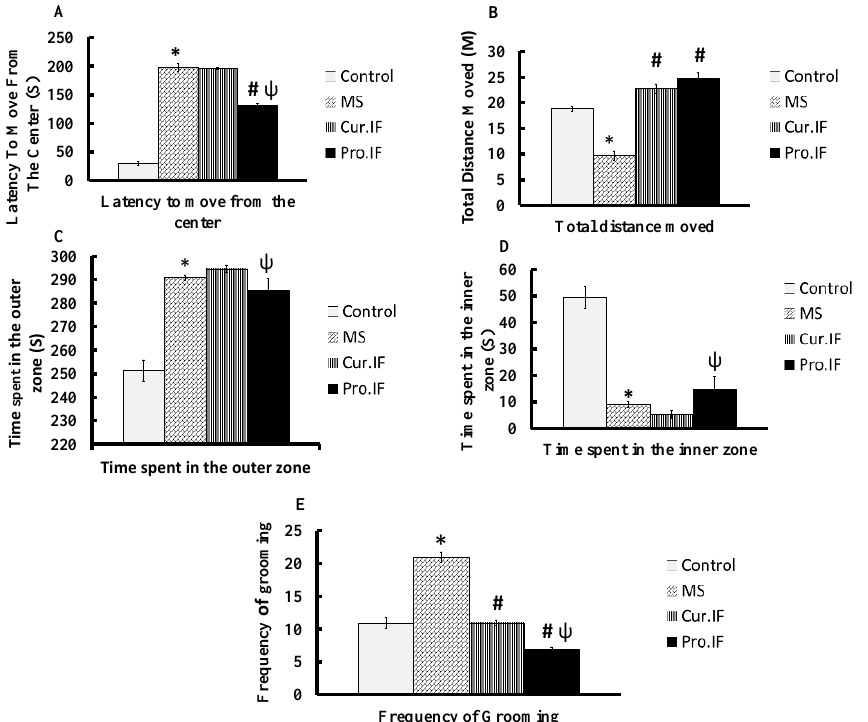
Figure 3. Effect of HFD and/or pro. and cur. IF on ( A ) latency to move from the center, ( B ) total distance moved, ( C ) time spent in the outer zone, ( D ) time spent in the inner zone, and ( E ) frequency of grooming in the open field test. Data are expressed as mean ± SEM ( n = 10). * HFD significant vis. control group, # pro. and cur. IF significant vis. HFD group, ψ pro. IF significant vise cur. IF.